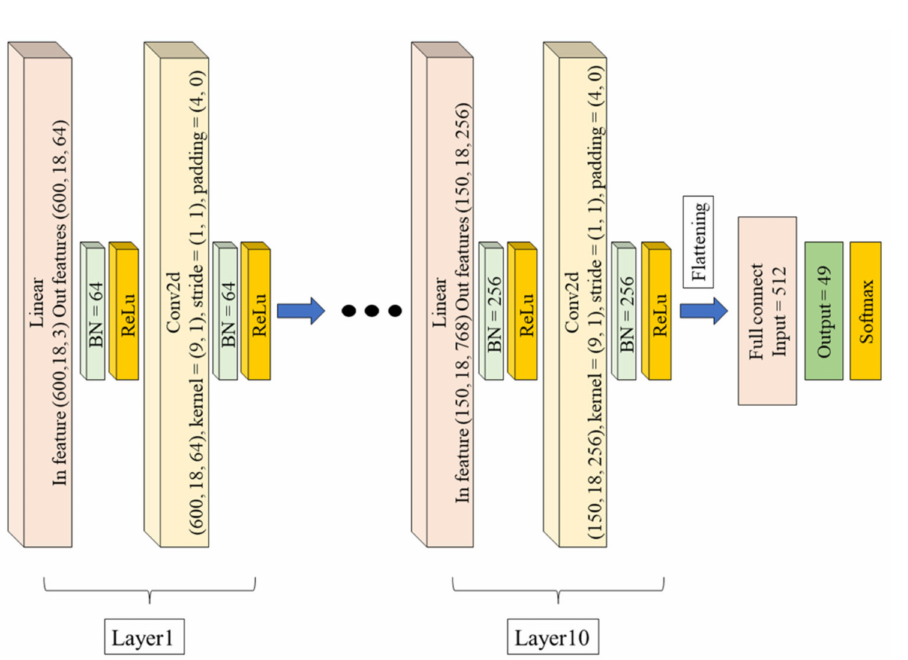
Figure 4. The structure of the 10-layer linear-map